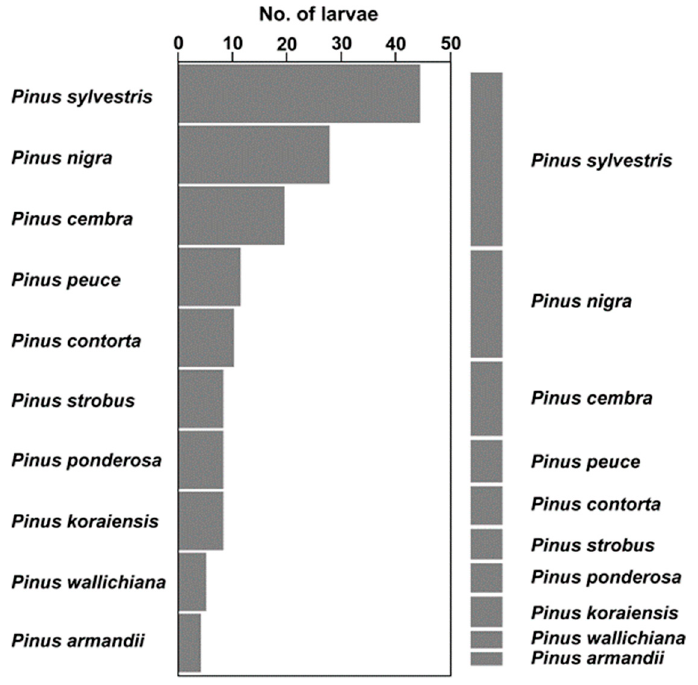
Figure 1. Bars showing the number of larvae, which chose specific food ( left side ), and a mosaic plot ( right side ) showing proportion of chosen pine species by the pine-tree lappet larvae ( Dendrolimus pini L.) in the multi-choice (10 options) experiment.